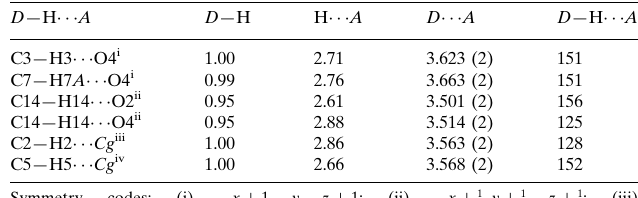
Hydrogen-bond geometry (A˚ , (cid:2)